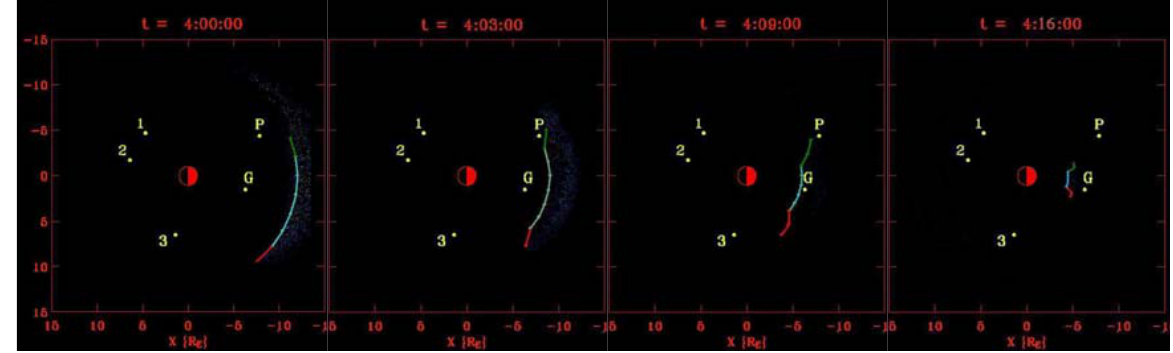
Fig. 6. Snapshots of the superimposed ion and electron dispersionless injection boundary in the simulation.